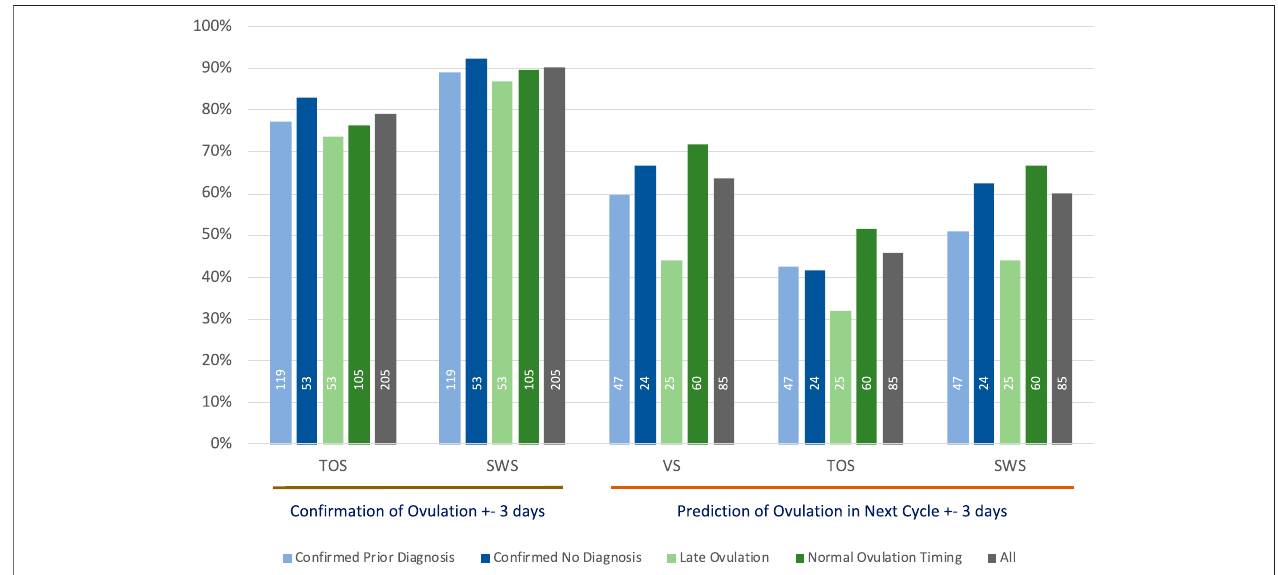
FIGURE2| The±3 days%accuracyofcon fi rmationofovulationandpredictionofovulationinsubsequentcyclesusingmediandayofovulationpredictionmethod, annotated with numbers of cycles contributing to each analysis.